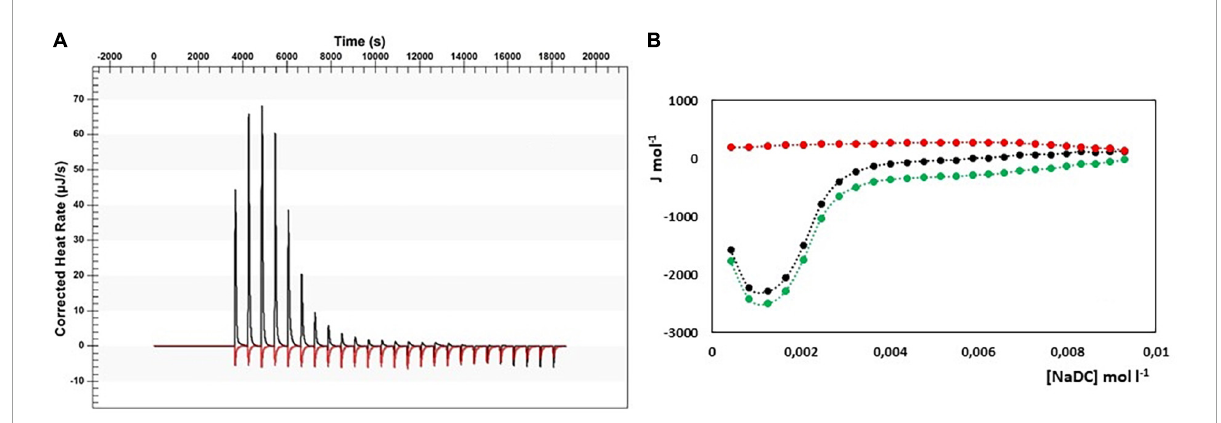
FIGURE6 (A) Heat rate ( µ J s − 1 ) vs. time profiles obtained from 25 injection each of 10 µ L of NaDC 40 mM into a 960 µ L reaction cell filled with a pectin solution 1 g L − 1 (black) compared with the dilution of NaDC 40 mM (red); (B) the dependence of the enthalpy changes vs. NaDC concentration in the reaction cell. Black dots represent the interaction enthalpy between pectin and bile salt, the red dots the dilution enthalpies of bile salt and the green dots their difference.